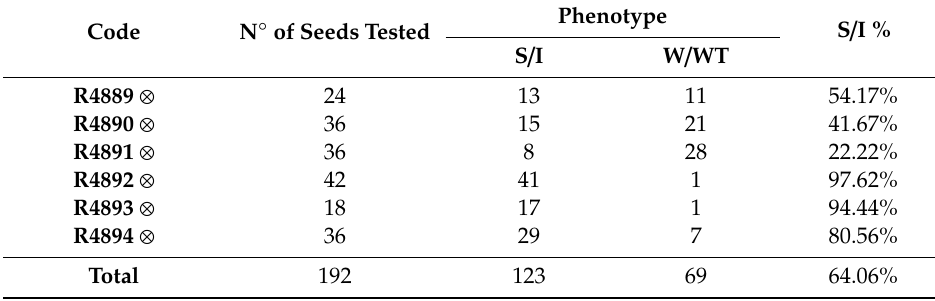
Table 2. Chen’s assay performed on F5 progenies. The S + I / total ratio is reported. S: Strong; I: Table 2. Chen's assay performed on F5 progenies. The S+I/total ratio is reported. S: Strong; I: Intermediate; W: Weak; WT: Wild Intermediate; W: Weak; WT: Wild Type.